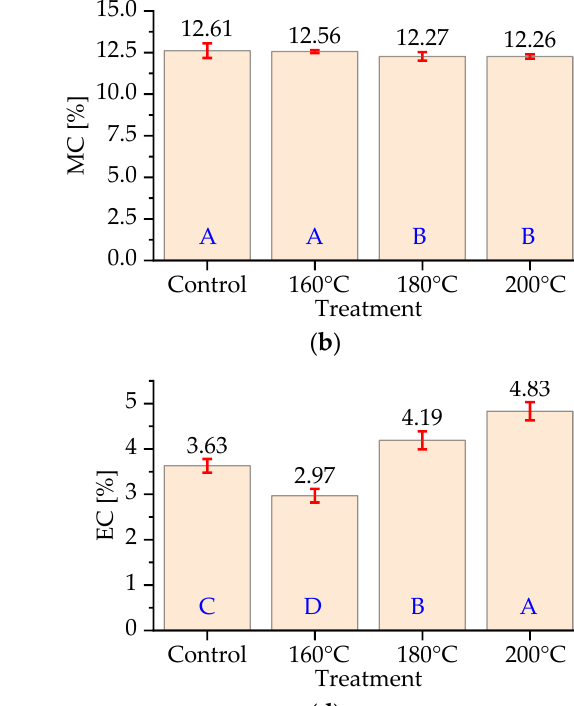
Figure 6. SEM image of veneer surface treated at 200 °C.